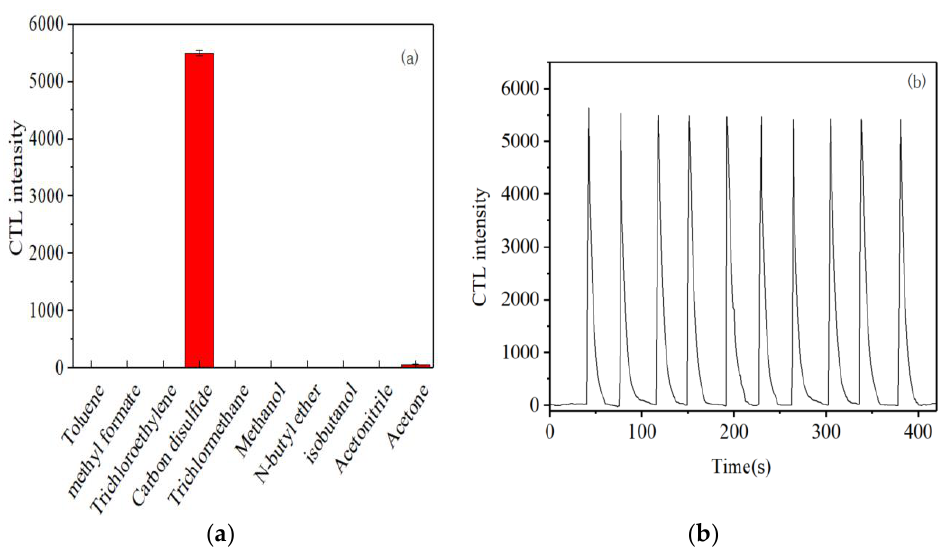
Figure 10. ( a ) CTL response of the sensor to different compounds; ( b ) results obtained from ten repetitions of CS 2 determination (flow rate: 280 mL/min; temperature: 162°C; concentration: 33.75 ppm).